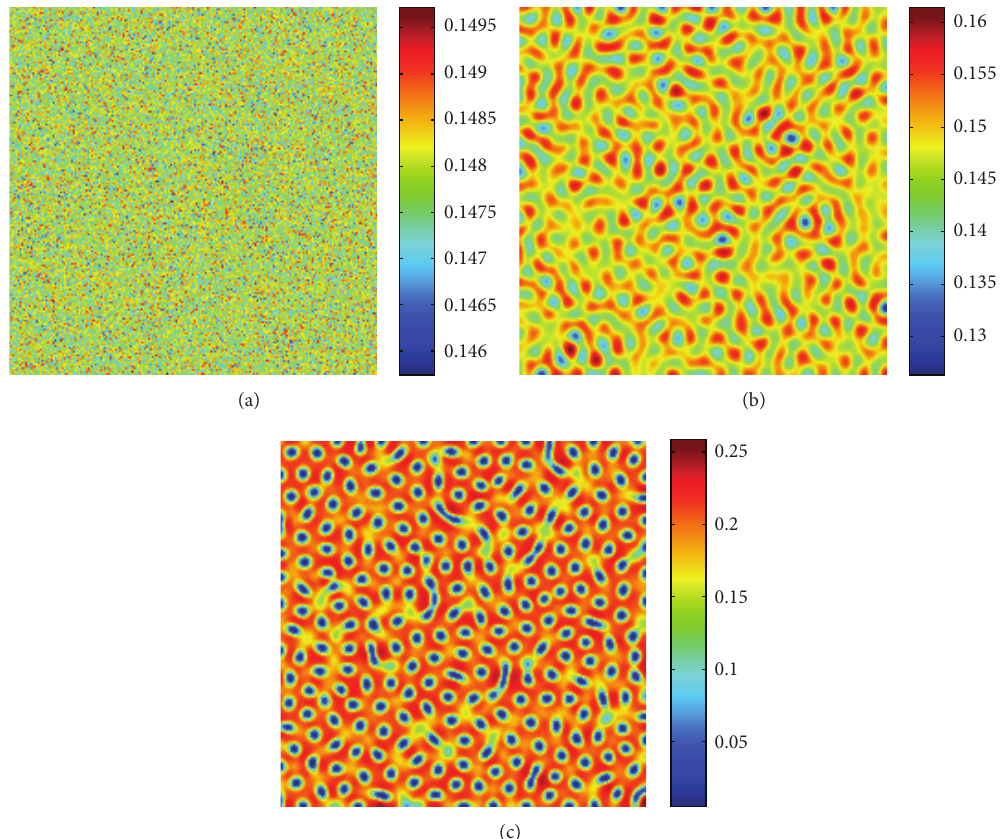
Figure 5: Snapshots of contour diagrams of the time evolution of algae at different points in time with 𝑁 = 0.31, 𝐷 2 = 0.5 . (a) 0 iterations, (b) 50000 iterations, and (c) 100000